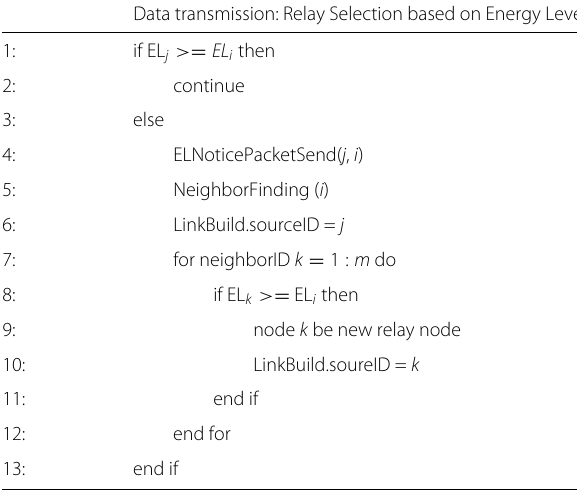
Table 2 Data transmission of